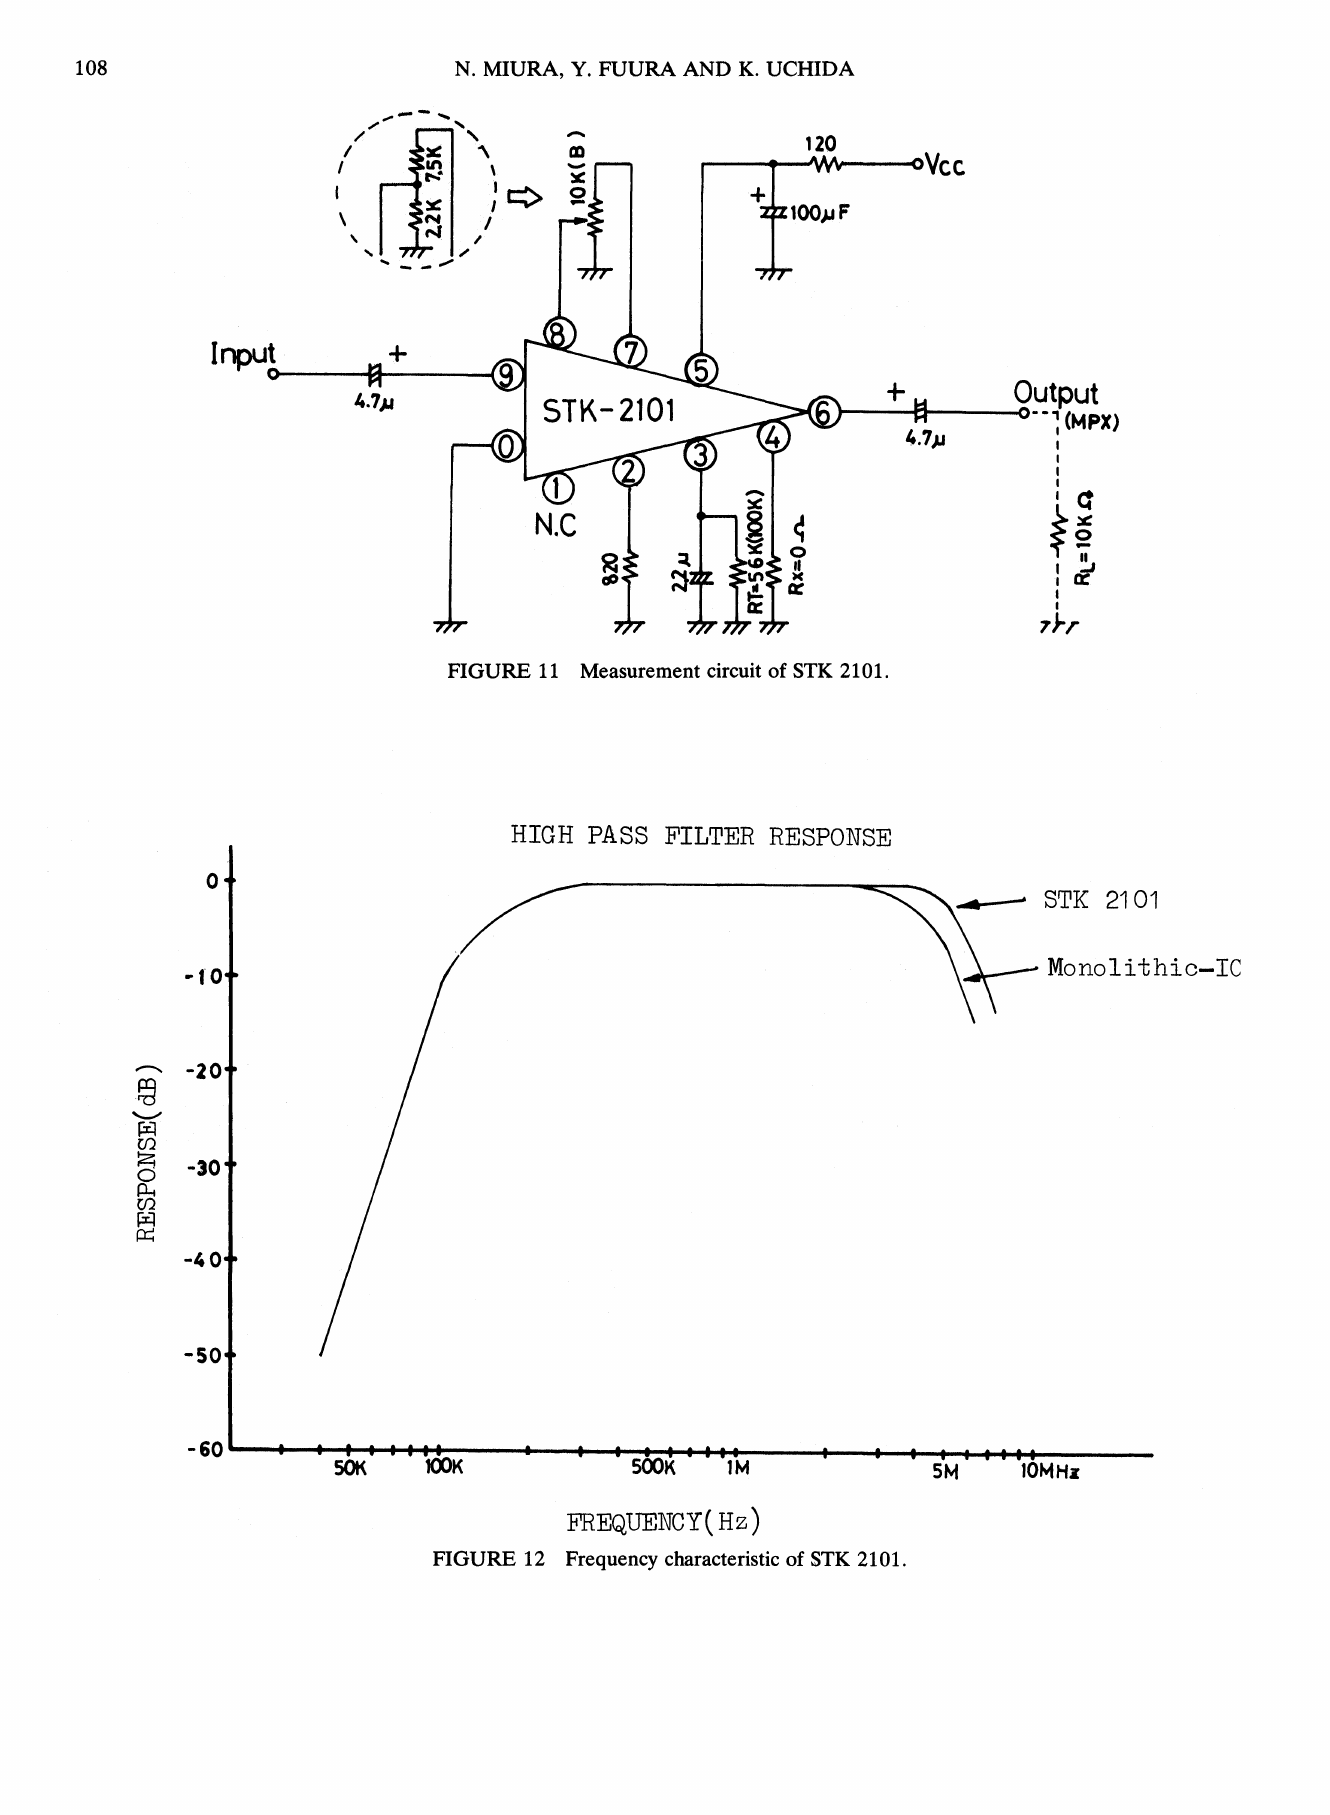
Frequency characteristic of STK FIGURE 12